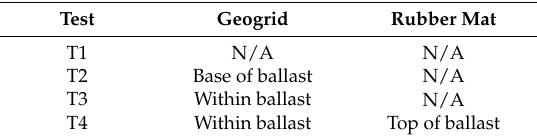
Table 3. Impact test program.